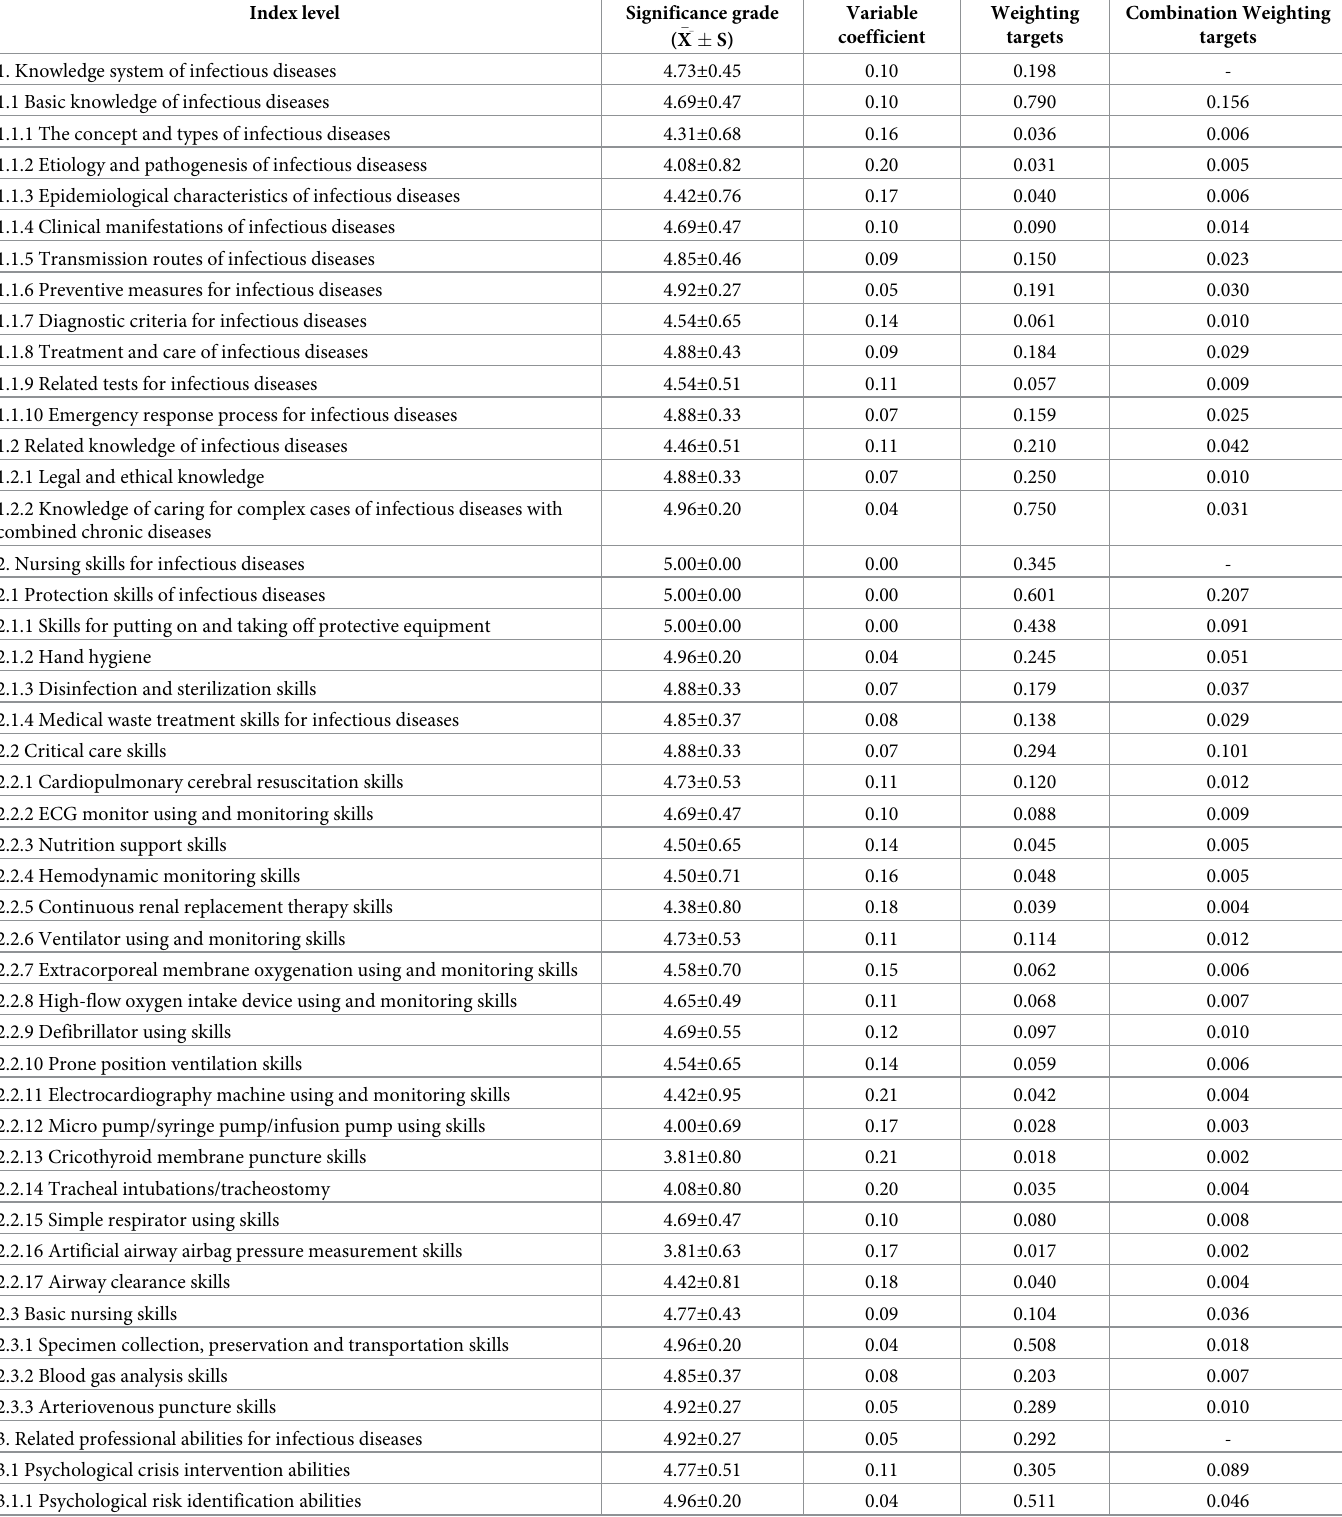
Table 4. Competency evaluation index system for front-line nursing staff during the outbreak of major infectious